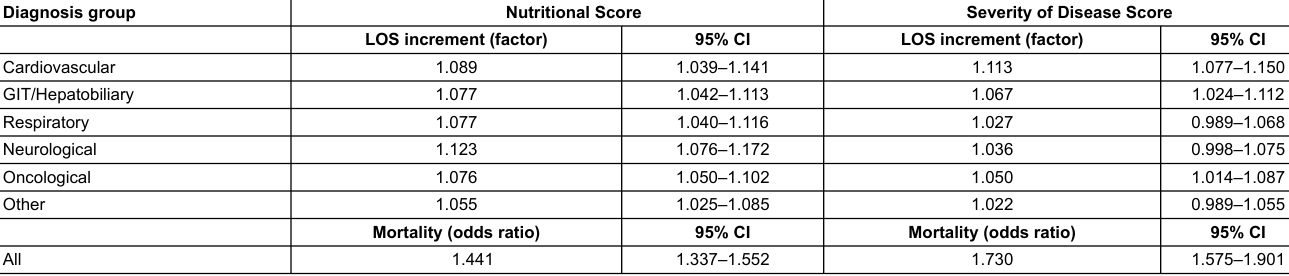
Table 3: Associations between Nutritional Score, Severity of Disease Score, and length of stay, as well as in-hospital mortality. Diagnosis group Nutritional